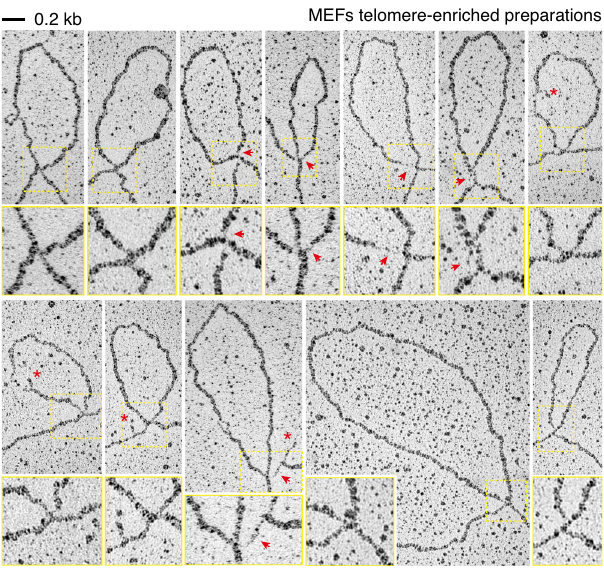
Fig. 3 I-loops often occur in proximity of strand damage. High magni fi cation images of i-loops observed in telomere-enriched fractions of the experiment described in Fig. 2. A 2X enlargement of the area inside the yellow rectangle is shown under each loop. Red arrows indicate regions of single-stranded DNA at the loop junction, while red asterisks indicate small fl aps in proximity of the loop